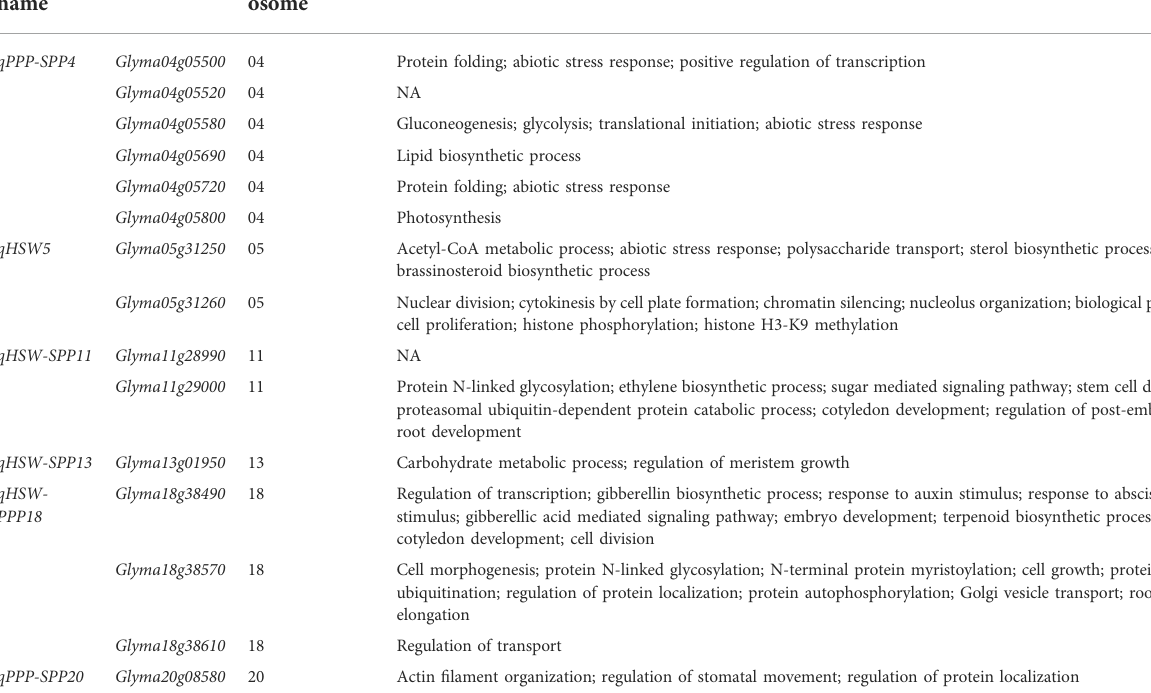
TABLE 4 Putative genes underlying six QTLs and their gene